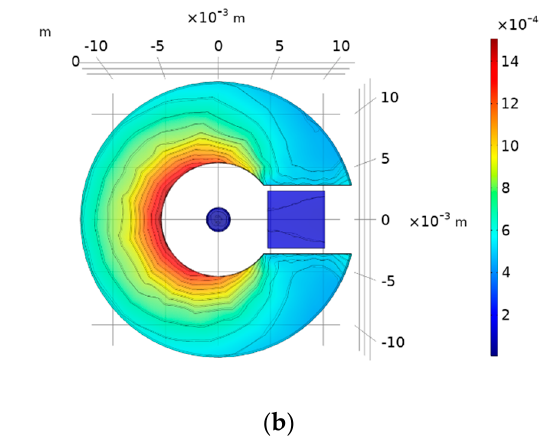
Figure 4. Simulation diagram of the magnetic ring structure: ( a ) simulation model, and ( b ) magnetic flux density distribution cloud map.